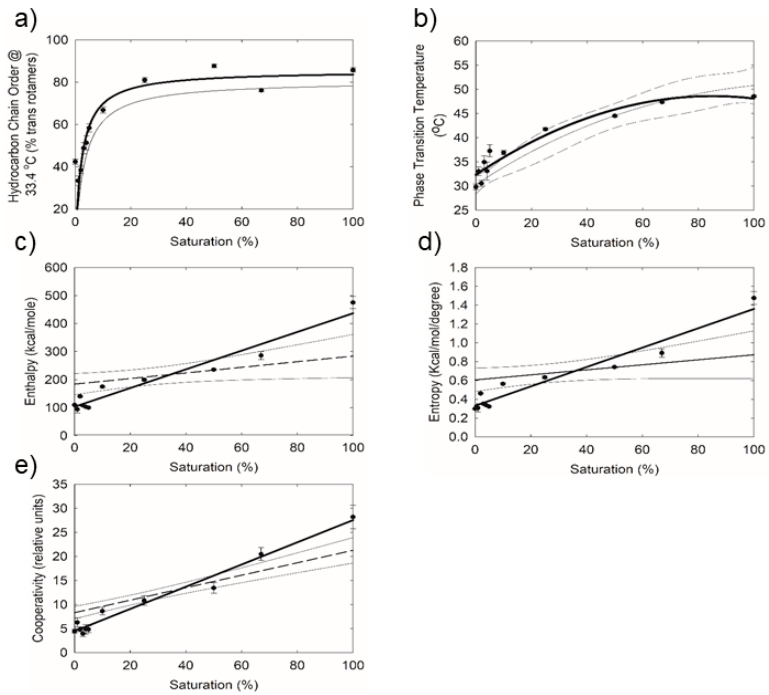
Figure 4. Lipid phase transition parameters for human tear lipid that was mixed with catalytically hydrogenated tear lipid from the same pool: ( a ) hydrocarbon chain order at the tear film surface temperature, ( b ) Phase transition temperature, ( c ) change in enthalpy, ( d ) change in entropy, ( e ) cooperativity. The % saturation is the percentage of catalytically saturated tear lipid mixed with normal tear lipid. Data are the average ± the standard error of the mean. (---) Data from a study of meibum lipid for comparison (from [26]). (light large dashed) 95% confidence interval of meibum lipid data (from [26]). data (from